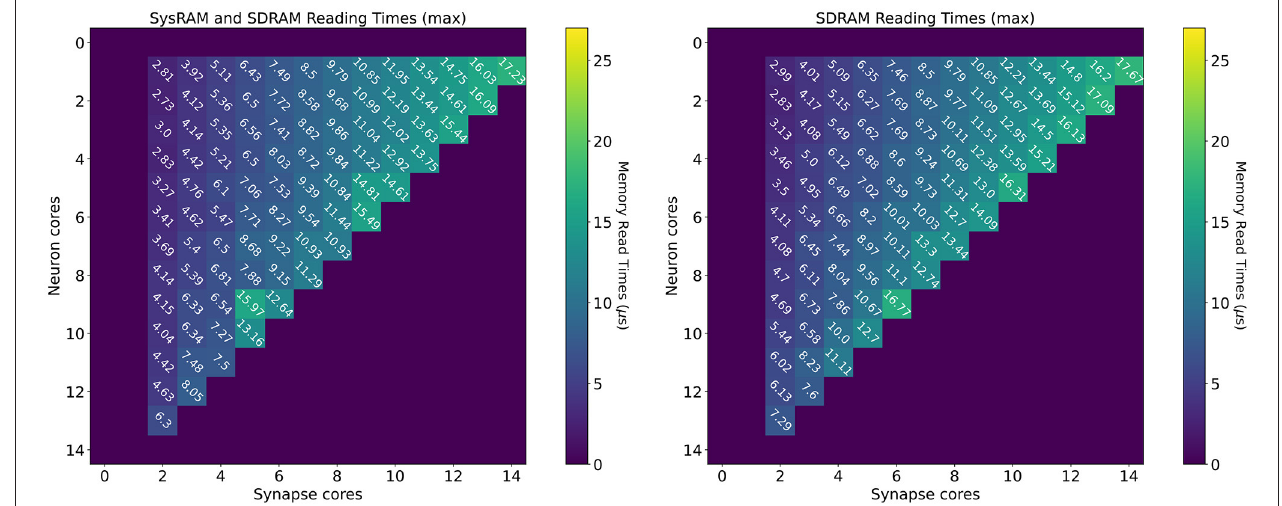
FIGURE 7 | Memory heatmaps showing worst case DMA reading timings for increasing Synapse and Neuron cores. Synapse cores are represented on the horizontal axis, target Neuron cores on the vertical. All the measured times are in µ s. The two plots represent the dual memory (left) and the SDRAM only case (right) . Purple blocks represent configurations not allowed by the